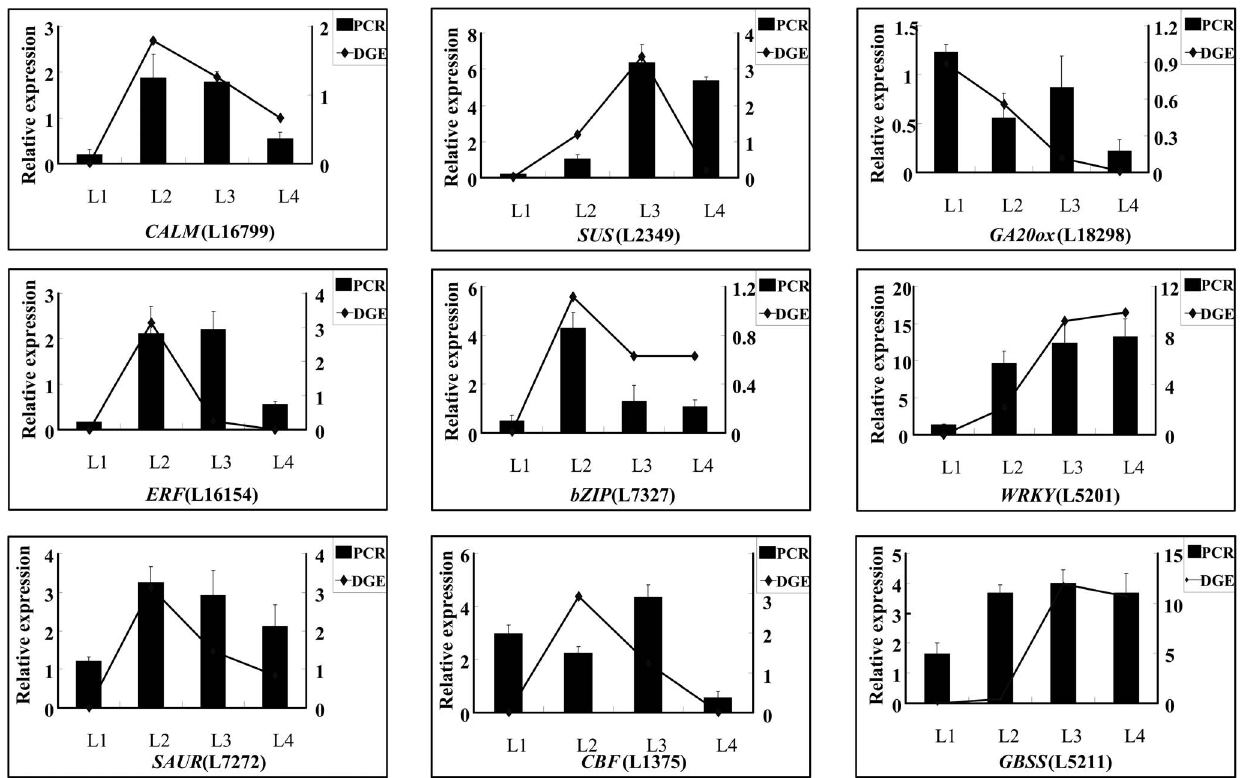
Figure 3. Validation of tag-mapped genes from three stages of lotus root with quantitative RT–PCR.